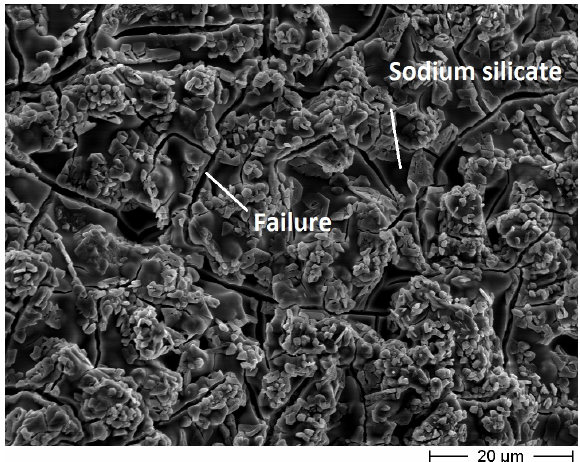
Figure 6. FE-SEM micrograph of the inner wall of the cementitious small hollow tube (recipe for maccherone No. 5) coated with sodium silicate. This coating presents some failures.